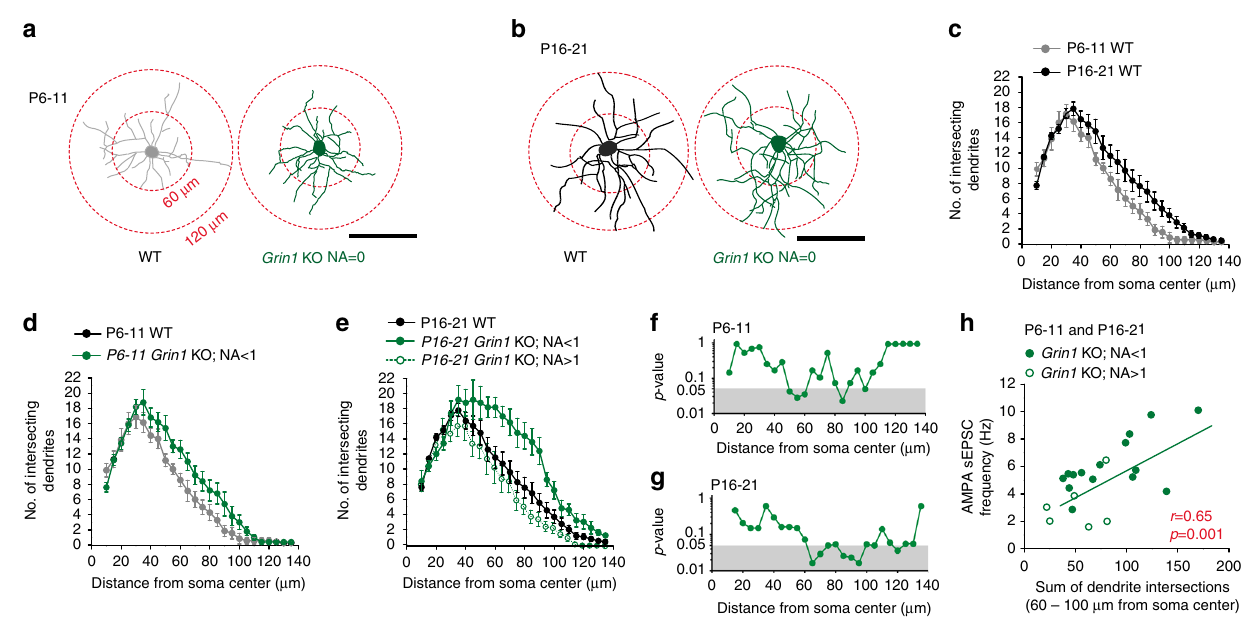
Fig. 4 NMDAR-hypofunction induces an increased dendrite complexity of CGE-derived NGFCs during postnatal development. a , b Single cell examples of the dendritic arborization of WT ( gray and black cells; P6-11 and P16-21, respectively) and Grin1 KO ( green cells ) CGE NGFCs. Examples of concentric circles employed for subsequent Sholl analyses ( red circles ). Scale bars, 100 μ m. c Sholl analyses plots of total number of dendrites intersecting each concentric circle (0 – 135 μ m from center of soma every 5 μ m) in P6-11 ( gray data ; n = 7) and P16-21 ( black data ; n = 15) WT CGE NGFCs. d Sholl analyses plots comparing morphology of P6-11 WT ( gray data ; n = 7) and Grin1 KO ( green data ; NA < 1; n = 6) CGE NGFCS. Note, P6-11 WT data ( gray ) in this panel is re- plotted from c . e Sholl analyses plots comparing morphology of P16-21 WT ( black data ; n = 15) and Grin1 KO CGE NGFCS ( green data ; fi lled vs. open circles denote data from NGFCs with NA < 1 and NA > 1, respectively; n = 11 and 6). Note, P16-21 WT data ( black ) in this panel is re-plotted from c . f , g Statistical comparison of the number of intersecting CGE NGFC dendrites at each concentric distance away from cell body between WT and Grin1 KO mice ( p -values are derived from Mann – Whitney U -test; Gray shaded area denotes p -values < 0.05). h Correlation of the sum of dendrite intersection (60 – 100 μ m from the soma center) and sEPSC AMPA frequency in individual NGFCs. r and p -values as indicated from straight-line fi t statistical analysis demonstrates a signi fi cant positive linear correlation between dendrite intersections and sEPSC AMPA frequency. All n values correspond to the number of cells recorded. Error bars denote (Supplementary Fig. 5c; dotted black and green arrows ). In summary, although a correlation between the sEPSC AMPA fre- quency and PPR exists at P16-21 (Supplementary Fig. 5b), this cannot fully underlie the abnormal AMPAR-mediated synaptic input precipitated by NMDAR-hypofunction.